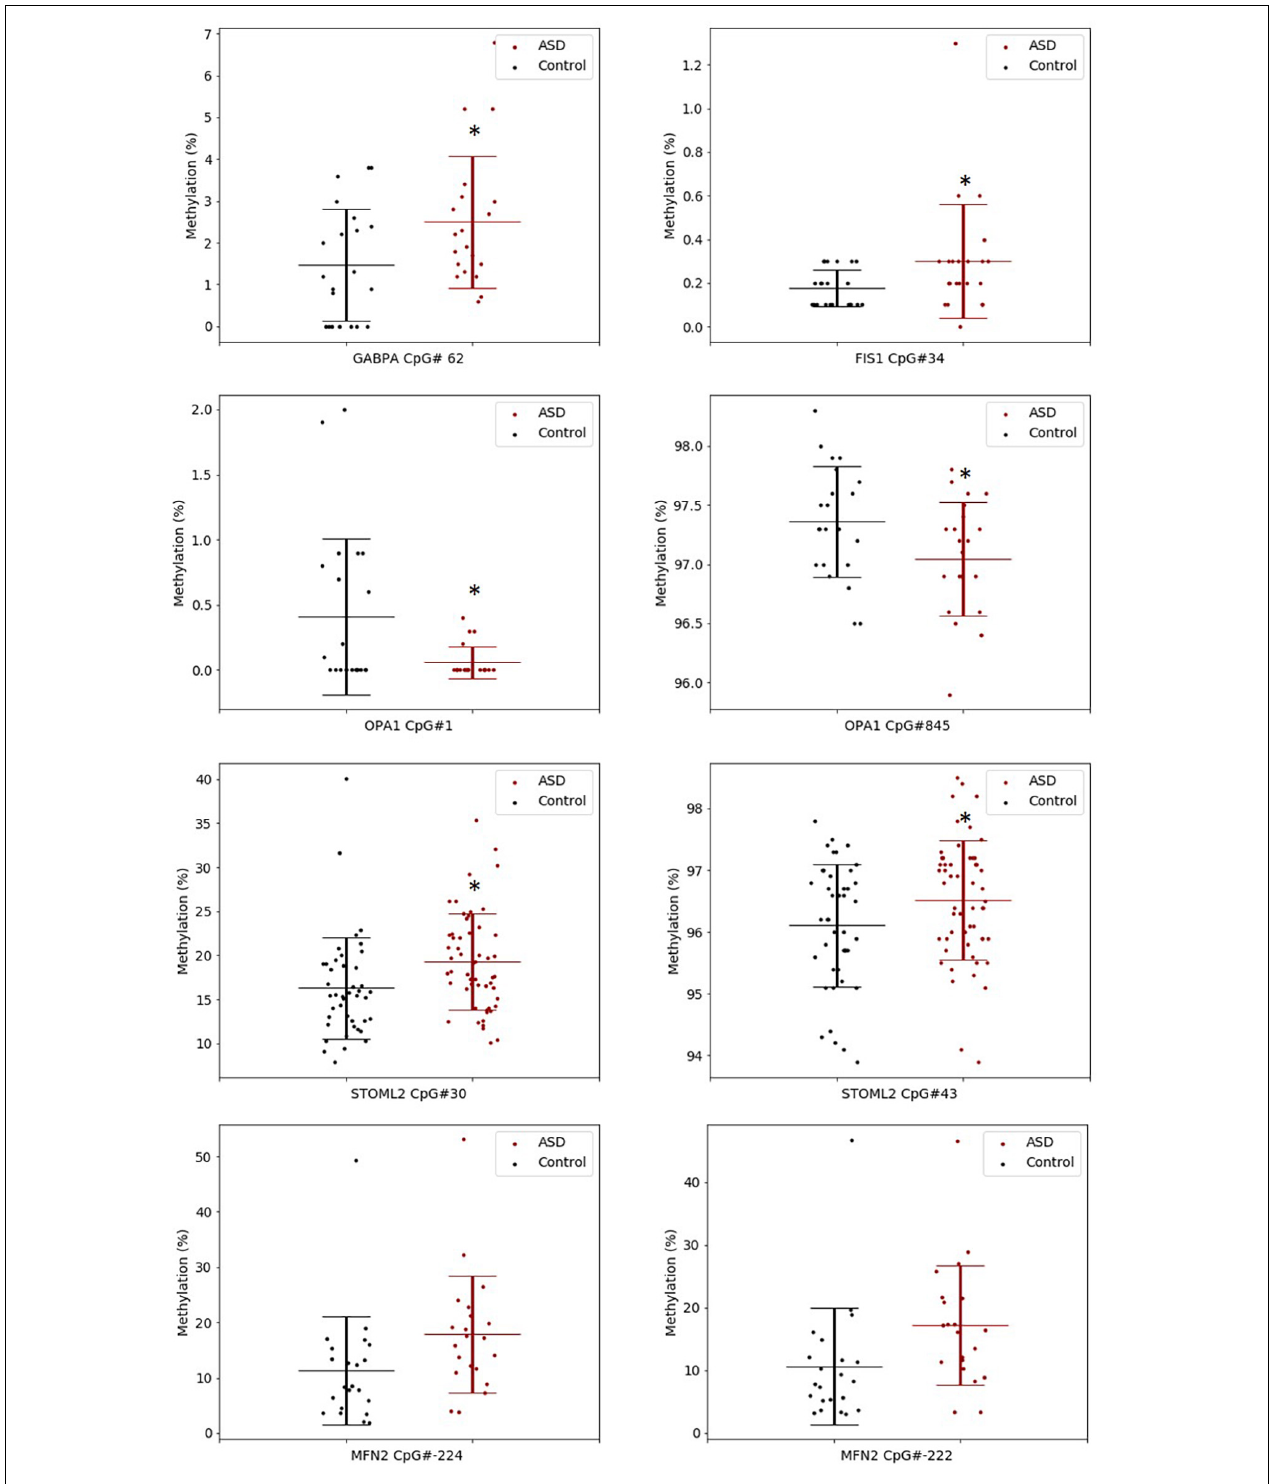
FIGURE 2 | Key gene regulators of mitochondrial biogenesis, fission and fusion are differentially methylated in ASD. Box plots show the percentage methylation of the differentially methylated CpG sites ( p < 0.05), measured using Targeted Next-Generation Bisulfite Sequencing of STOML2 (ASD n = 55, controls 44) and FIS , MFN2 , OPA1 , and GABPA (ASD n = 22, controls n = 22). Differential methylation was identified using a two-tailed unpaired t -test with unequal variance ( p < 0.05). Data represent the percent methylation in each individual at each site; box plots represent the mean percent methylation across either controls (black) or ASD (red) at each site; error bars represent standard